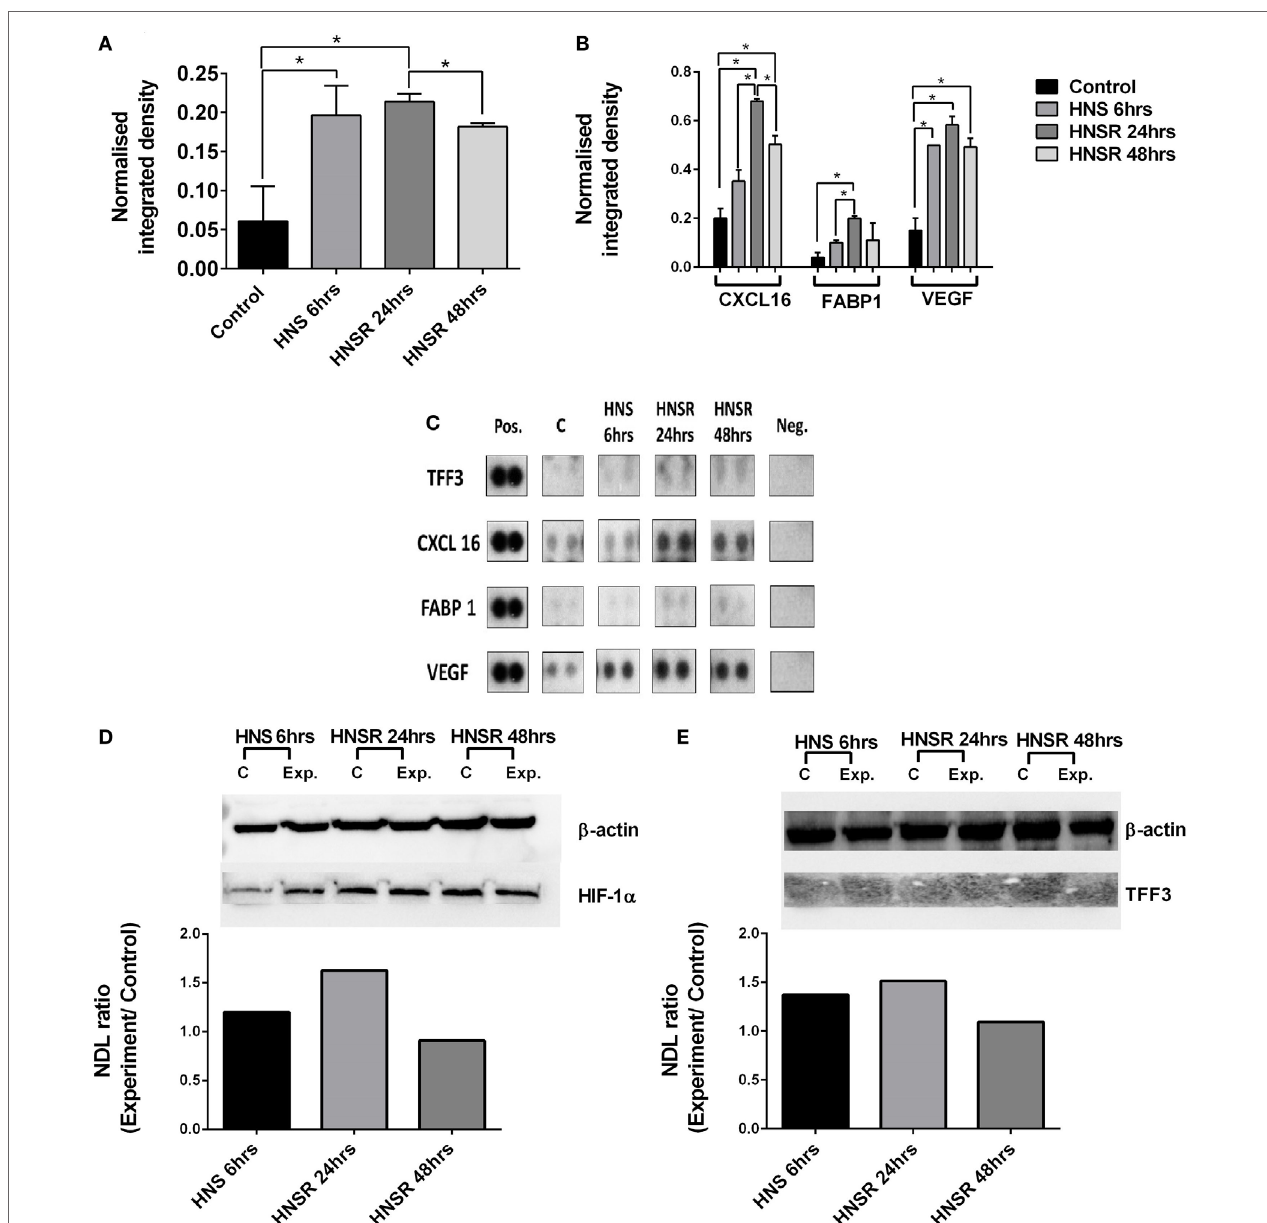
FiGUre 1 | Densitometric analysis of proteome array reactivities for tFF3 (A) and characteristic markers of hypoxia (FABP1, veGF) and inflammation (cXcL16) (B) using cell lysates from HK-2 cells exposed to hypoxia/nutrient starvation (HNs) and replenishment (HNsr) for 24 and 48 h . Densities obtained are shown in (c) . These were normalized to a reference (pos) and the background was subtracted. Data are presented as mean ± SD and were compared using Student’s multiple t -test. p < 0.05 was considered statistically significant. GraphPad Prism 6.07 was used for statistical analysis (GraphPad Software, La Jolla, CA, USA). HIF-1 α abundance is increased at the early replenishment time point when normalized to a housekeeping protein β -actin and compared to the normoxic control (D) . Normalized abundance of TFF3 (7 kDa) in cell lysates from HK-2 cells exposed to hypoxia/nutrient starvation (HNS) and replenishment for 24 and 48 h (e) . NDL, normalized density to loading control (Western